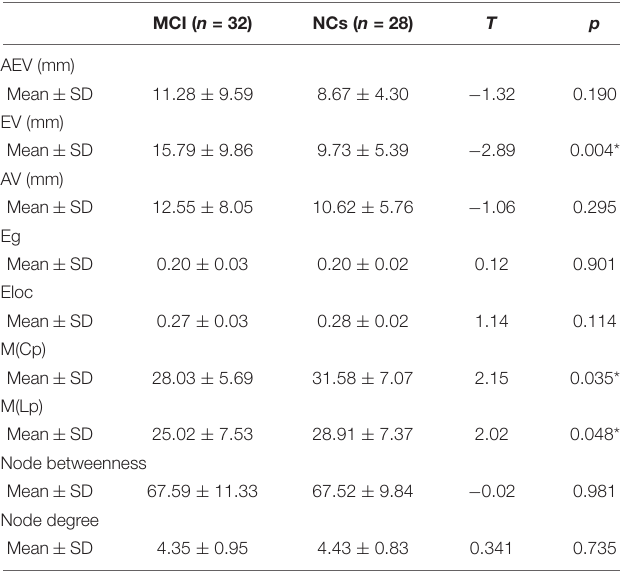
TABLE 2 | Differences in spatial navigation accuracy and the whole-brain network topology properties of patients with MCI and normal controls.